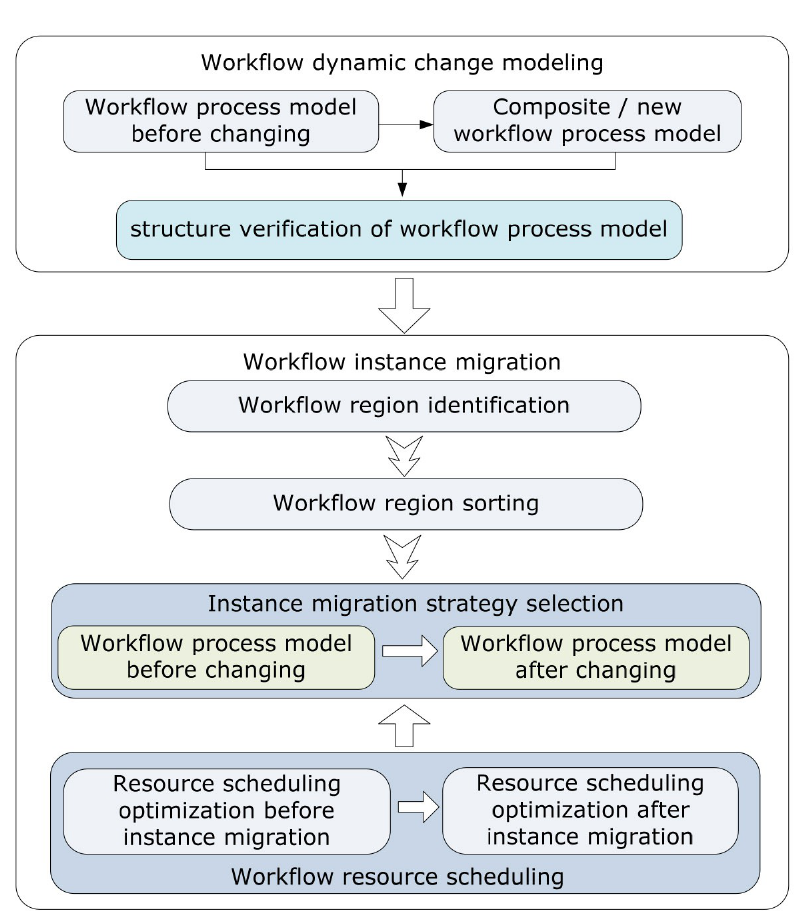
Figure 1. Process framework of the workflow instance